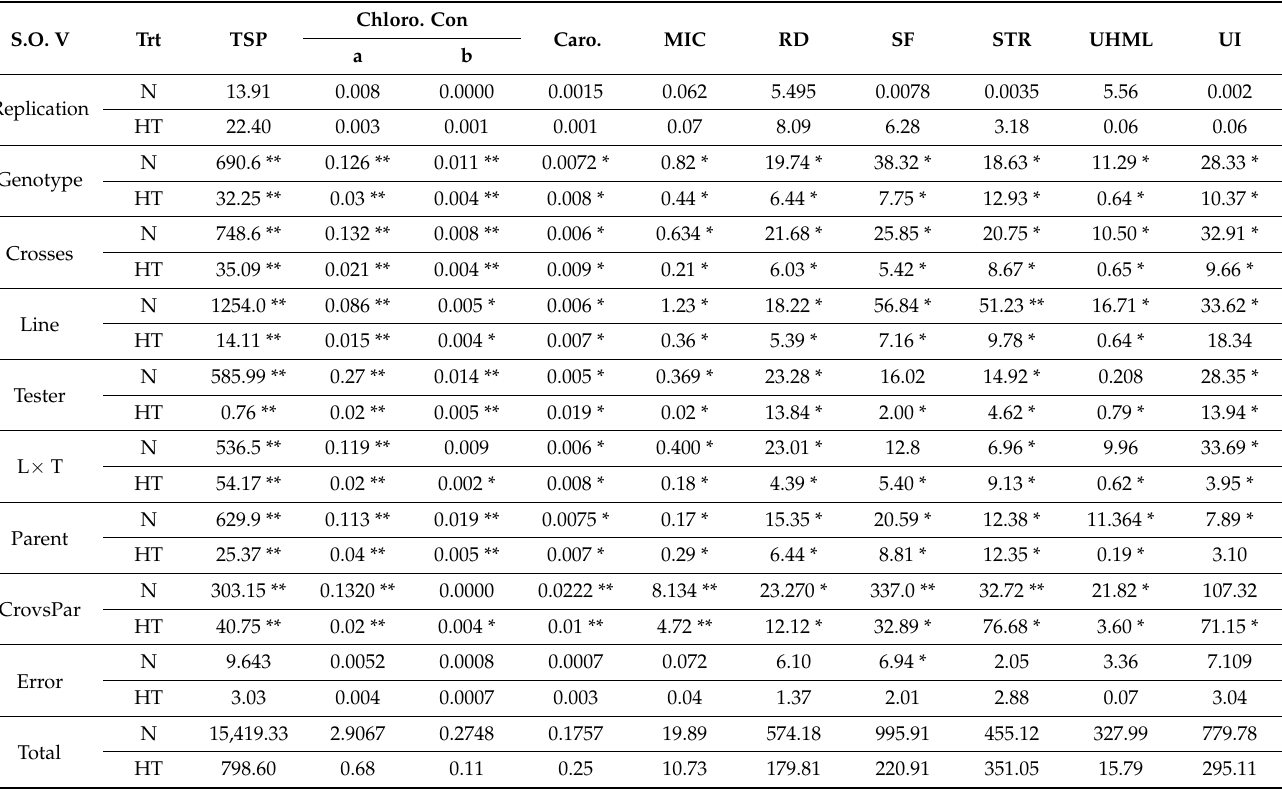
Table 7. Second year mean squares of line × tester analysis for various characters under normal and high temperature stress